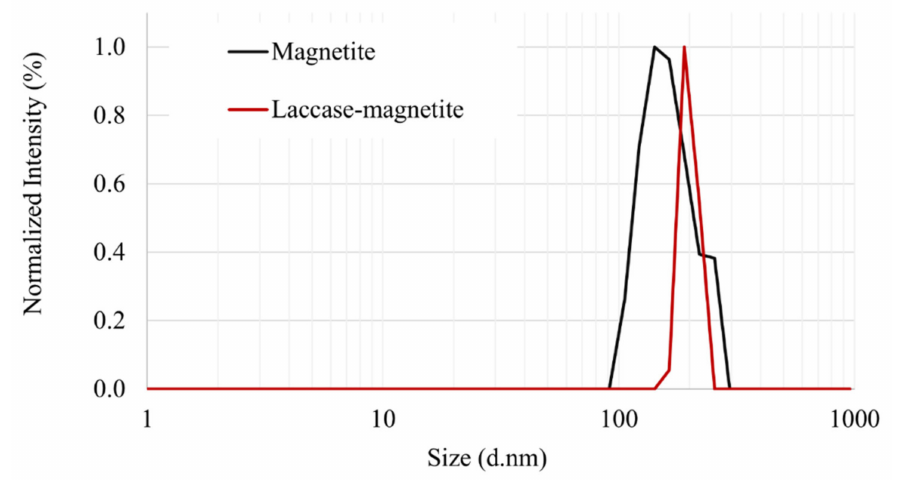
Figure 4. Zetasizer results of magnetite nanoparticles and Laccase-magnetite nanoparticles. Silanization of silica nanoparticles was confirmed by FTIR analysis. Figure 5 shows the average FTIR spectra of magnetite and Laccase-magnetite. Two bands of ν (Fe-OH), identified at 1620 and 3160 cm − 1 , represent the vibration of the hydroxyl groups on the magnetite surface, as reported in other studies [37], particularly, the peak at 3160 cm − 1 is attributed to single bond OH [38]. Therefore, it is possible to affirm that these peaks correspond to the surface of the magnetite. In the case of Laccase-magnetite, there are two significantly different peaks compared to the spectrum of magnetite, the first one observed at 3350 cm − 1 was attributed to the NH stretch present in the laccase amides [39]. The second peak was observed at 1080 cm − 1 characteristic of the Si-O-Si bond. This band confirms the silanization of the magnetite surface as part of the functionalization process for enzyme immobilization [9].